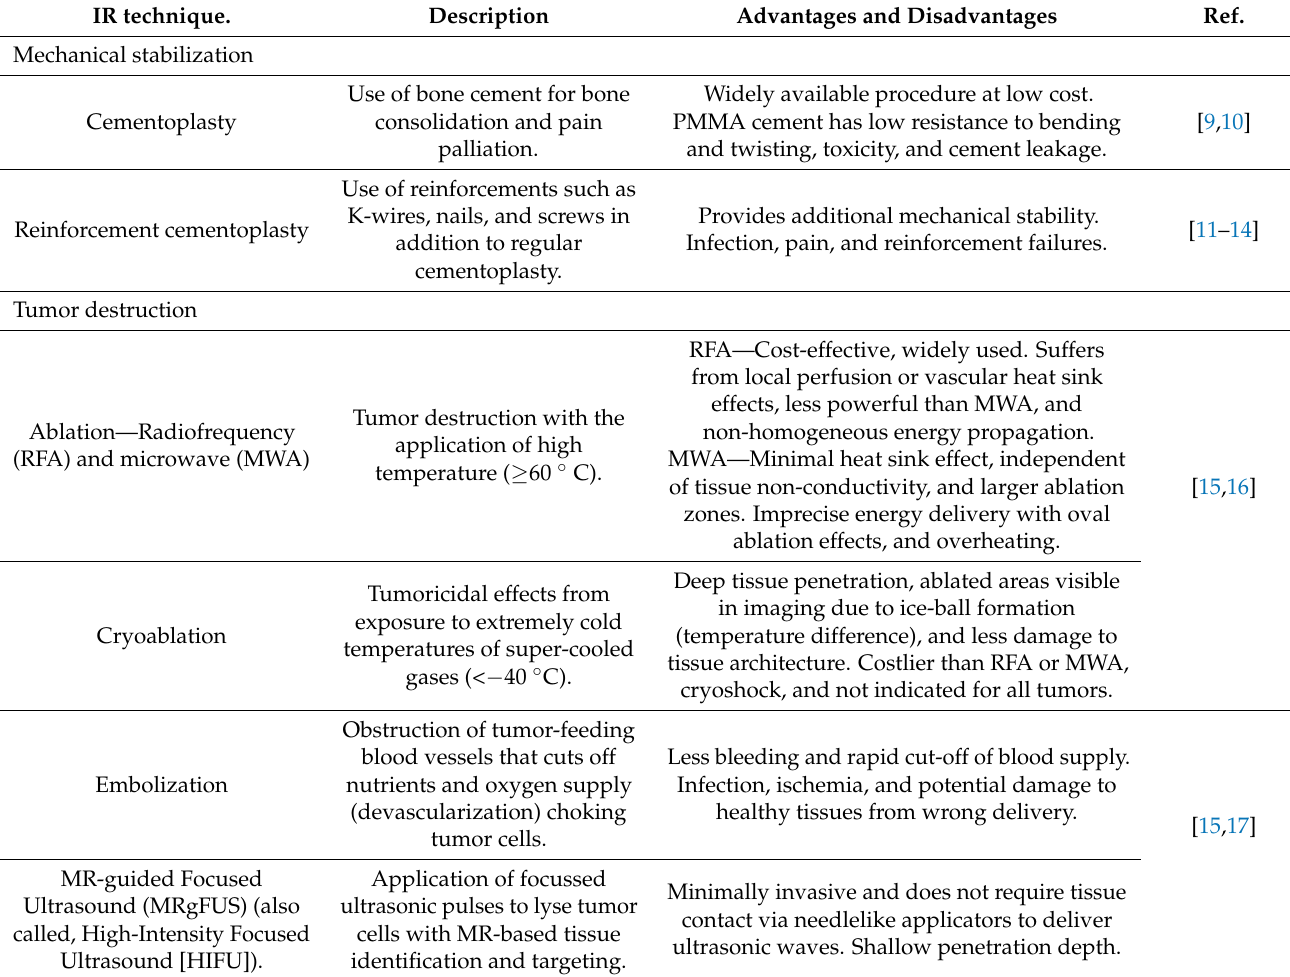
Table 1. Currently available therapies for the management of bone metastases with IR. IR technique. Description Advantages and Disadvantages